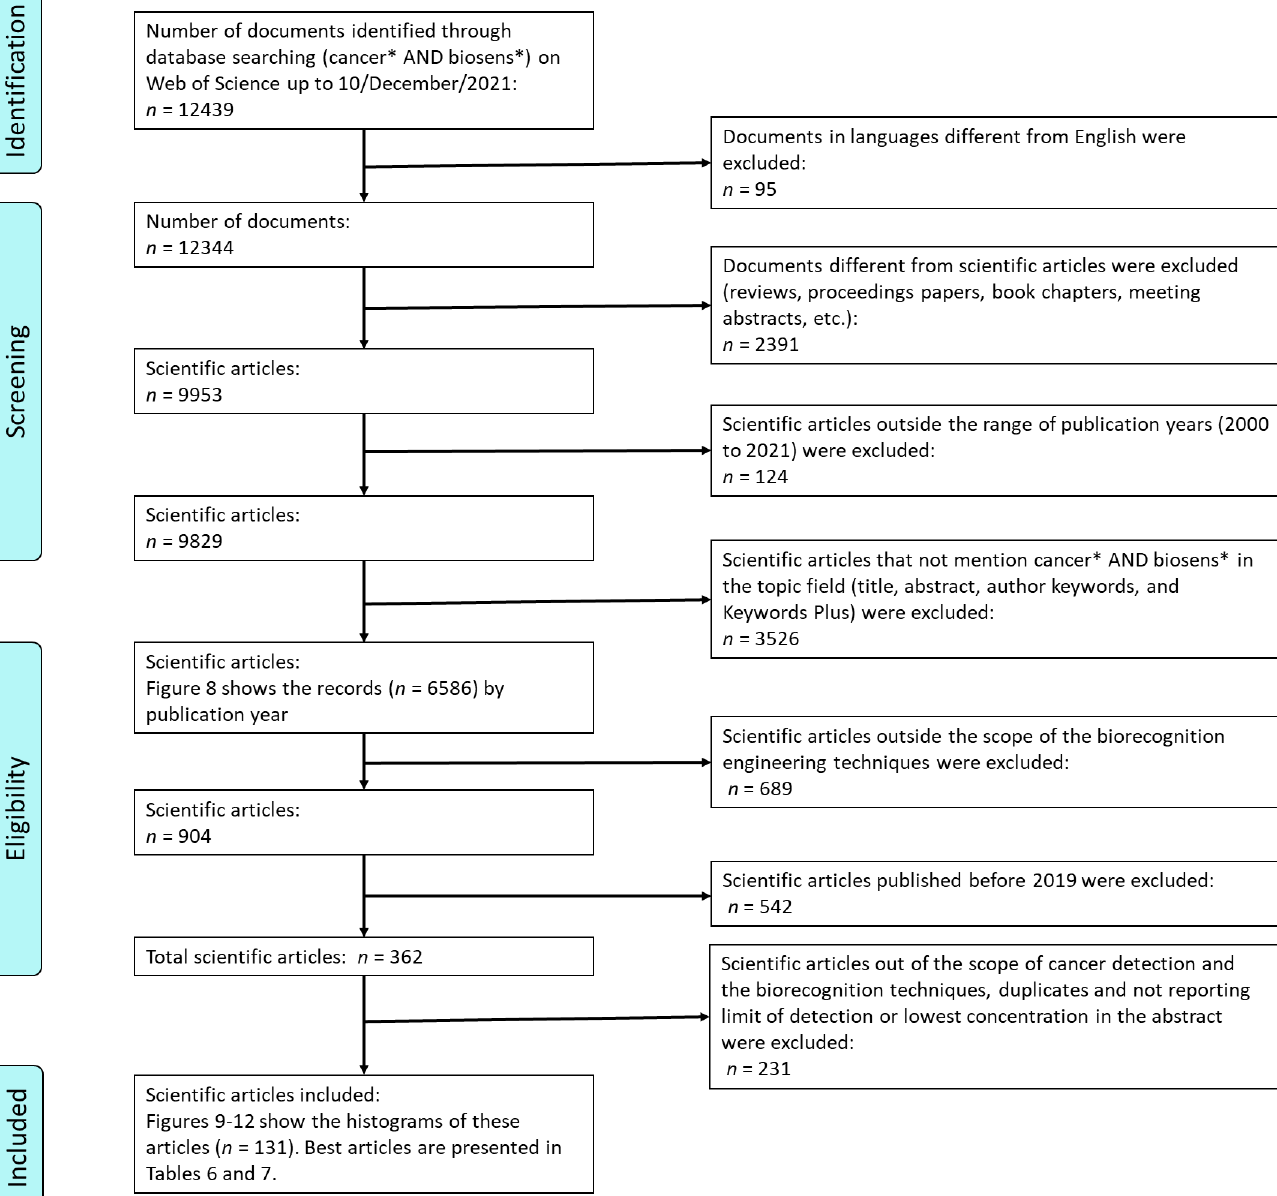
Figure 1. PRISMA flowchart of the article selection process for this study.